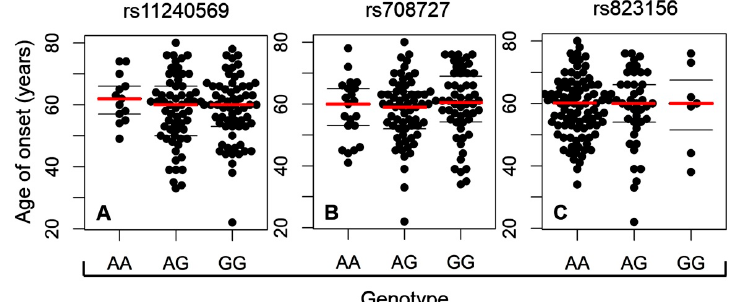
Figure 2. Correlation between age of onset of idiopathic PD and the particular genotypes at each tested A1 SNP: ( A ) rs11240569, ( B ) rs708727, ( C ) rs823156. The correlation for each SNP involved 138 PD patients. Twelve patients out of 150 patients in PD cohort have been excluded from the correlation due to discrepancies about the age of PD onset in their documentation.